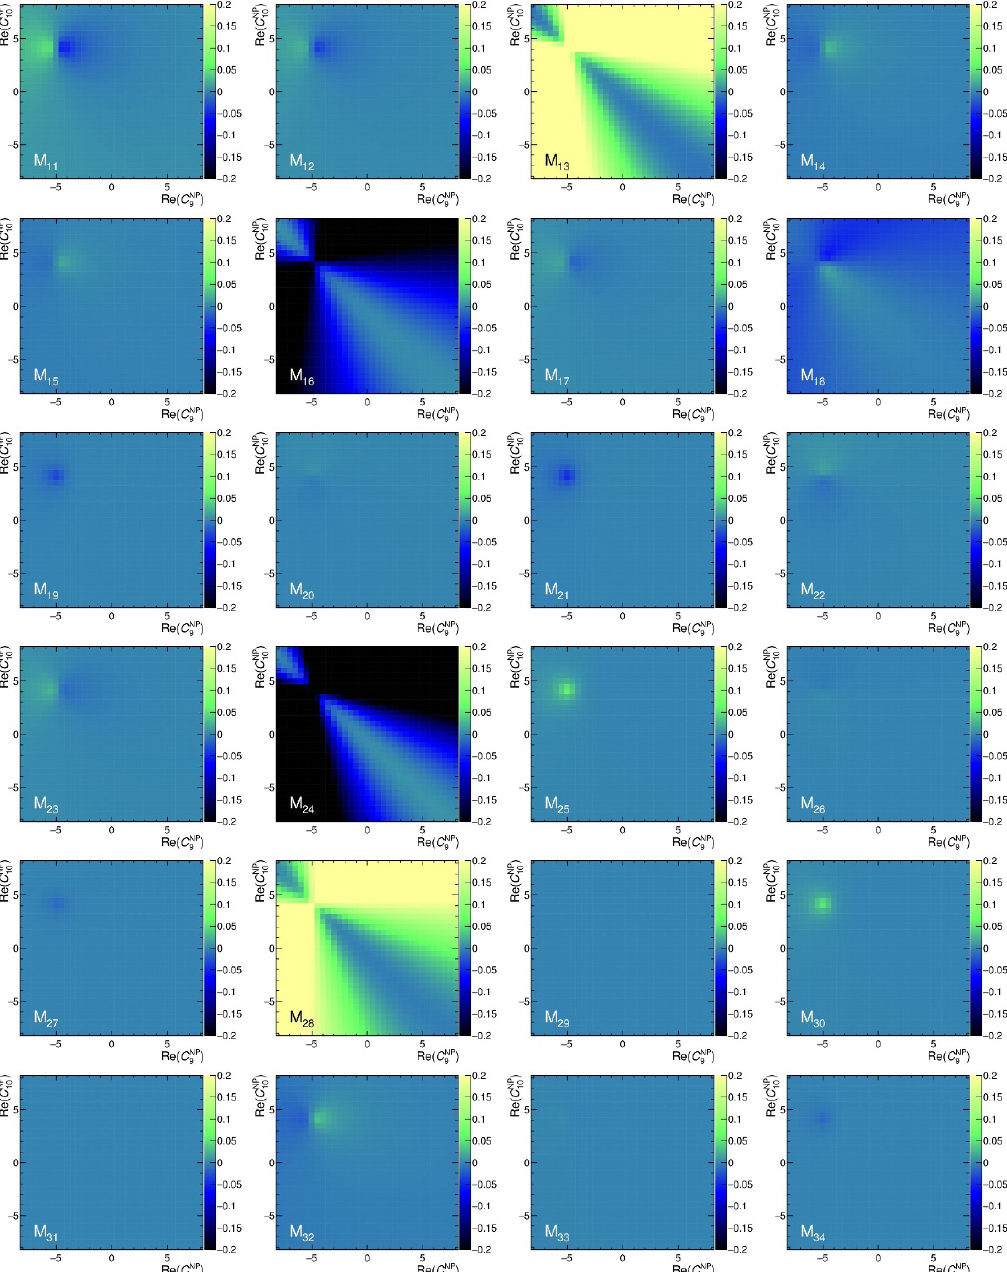
+ (cid:22) (cid:0) decay b ! (cid:3) (cid:22) = 1 is used. b